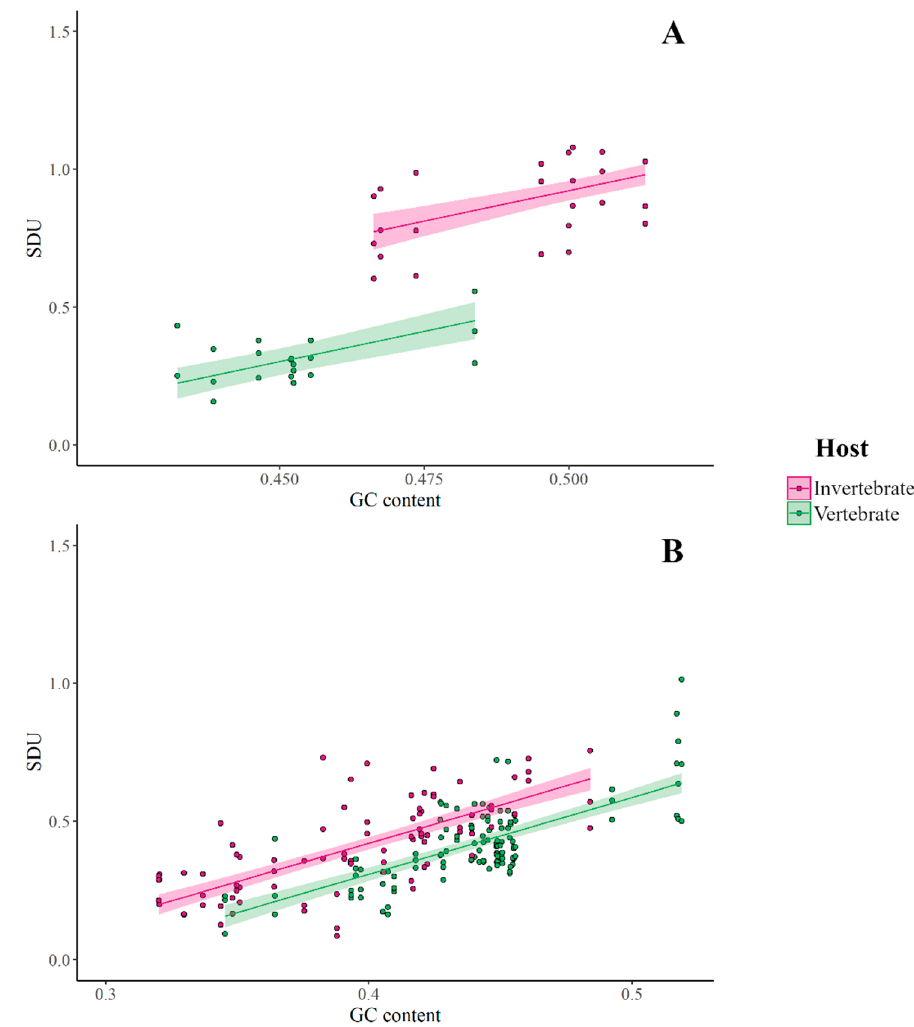
Figure 4. Comparison of SDU CpG for all frame positions between invertebrate- and vertebrate-specific ( A ) Flaviviridae and ( B ) Rhabdoviridae , plotted against the overall GC content of the coding sequences (Supplementary Table